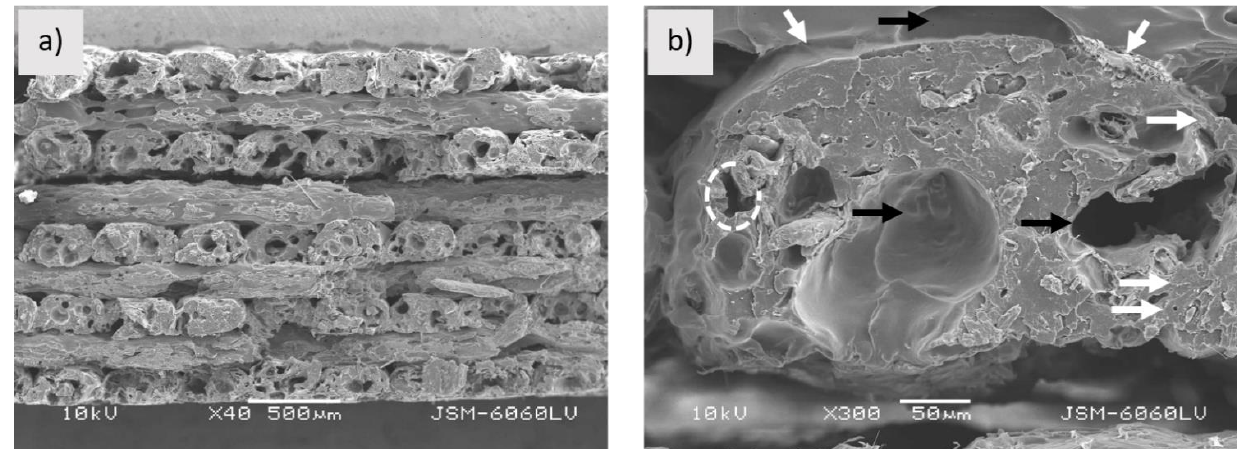
Figure 5. Sample PLA-Woodfill_3D; ( a ) fractured surface of sample (mag. 40×), ( b ) fractured surface of printed filament (white arrows point to area where two printed filaments and layers are firmly connected; dotted circle shows gap between wood fibre and matrix, black arrows point to cavities) (mag. 300×).